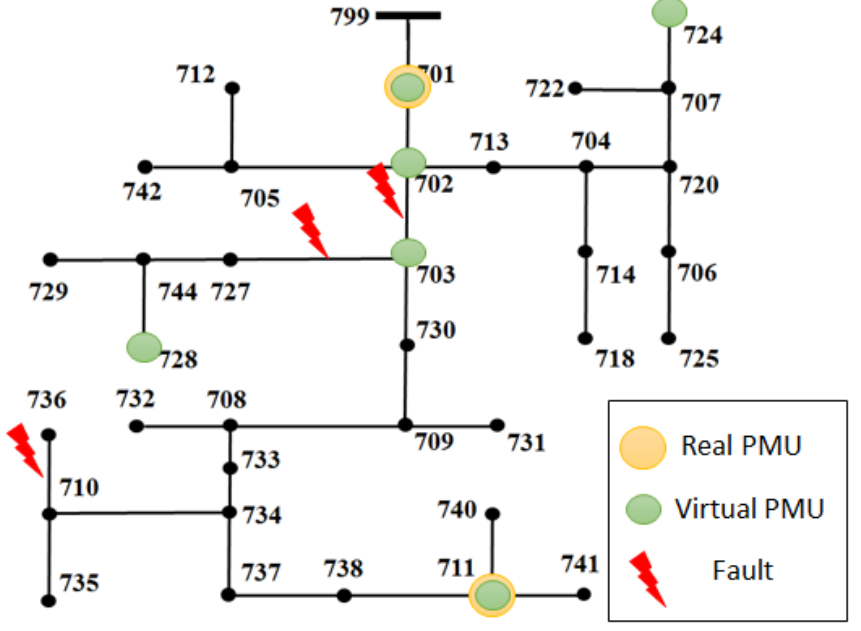
Figure 7. One-line diagram of the IEEE 37-Nodes Test Feeder